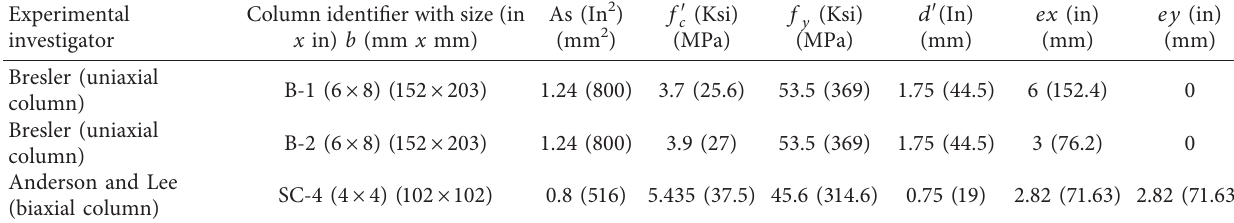
Table 6: Experimental testing data [22].